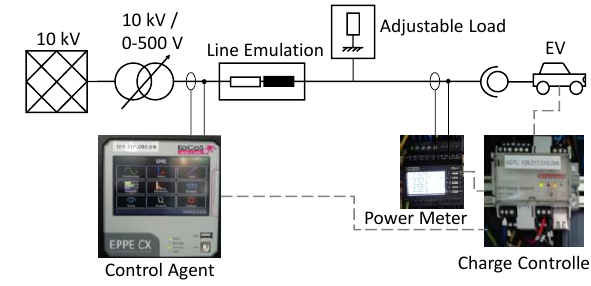
Fig. 12. Possible hardware configuration of grid-supporting charging